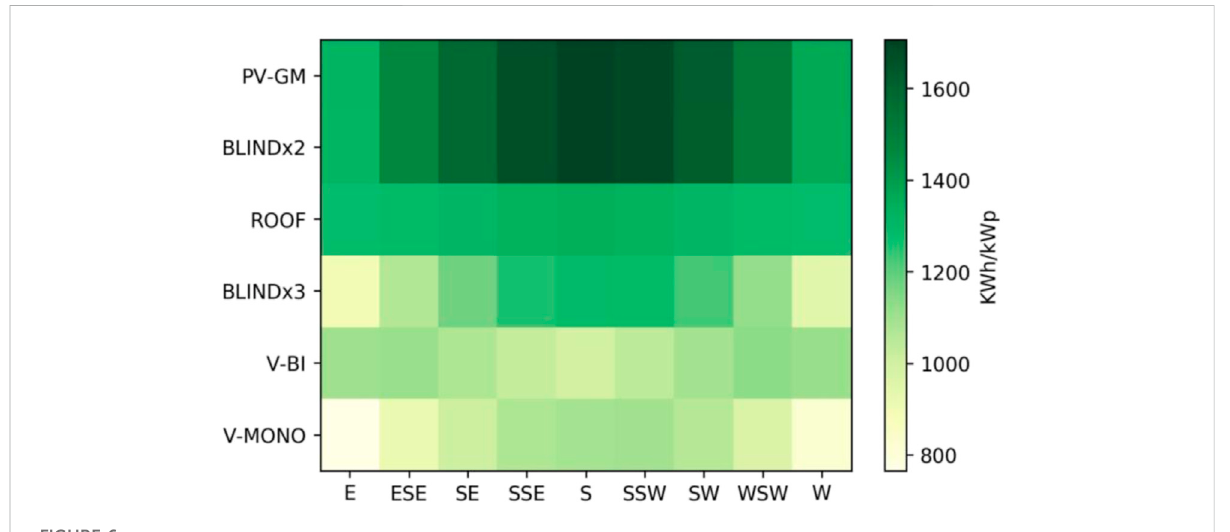
FIGURE 6 Speci fi c yield for each con fi guration in different orientations.